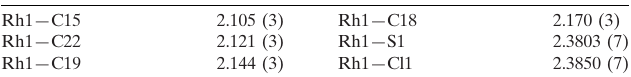
Selected bond lengths (A˚ ).